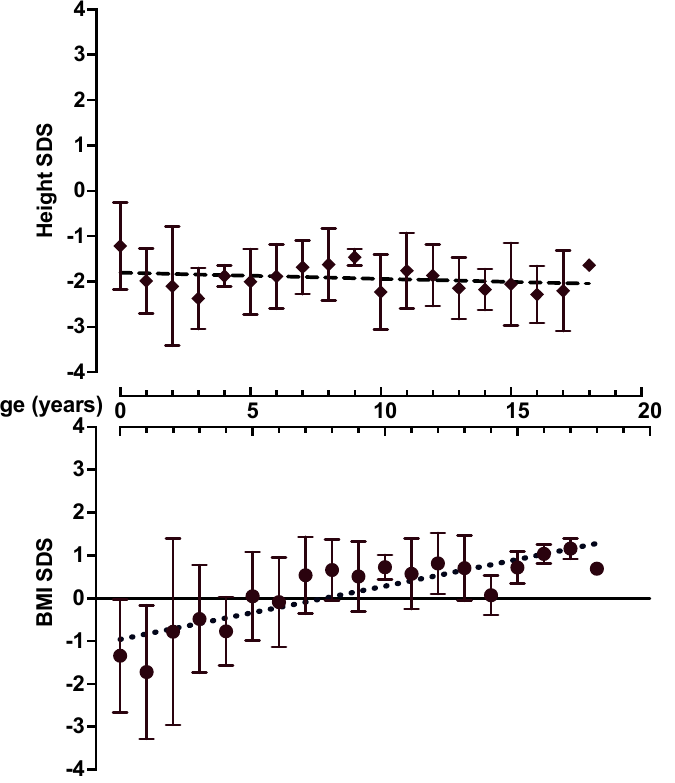
Figure 1. Mean height and BMI SDS trend related to age for all NPR2 probands. In three probands (P4, P5, and P7), we found additional skeletal findings, such as a shortened metacarpal bone of the fourth and fifth finger, a slightly shortened proximal part of the lower and upper extremities, clinodactyly and micrognathia (Table 1). Three probands (P3, P7, and P10) met national guidelines for growth hormone treatment and were treated with recombinant human growth hormone (rhGH) (dose (range): 35–50 μ g/kg/day; duration (range): 8.5–68 months). P3 and P7 also received therapy with GnRH analogue (triptorelin embonate). Significant height gain was observed in P7 and P10. P7 started rhGH treatment at 10.75 years of age and had a height gain of +0.74 SDS in 5 years and 8 months (from − 3.14 to − 2.4 SDS). P10 started rhGH treatment at 5.9 years of age and had a height gain of +0.49 SDS in 8 months (from − 2.56 to − 2.07 SDS). In P3, therapy with rhGH and GnRH analogue was introduced at 13.25 years of age. After 13 months of therapy, there was no change in growth velocity (height SDS − 2.16 to − 2.17). The peak GH values, height gain, age at introduction of GH therapy and duration of therapy are shown in Table 2.